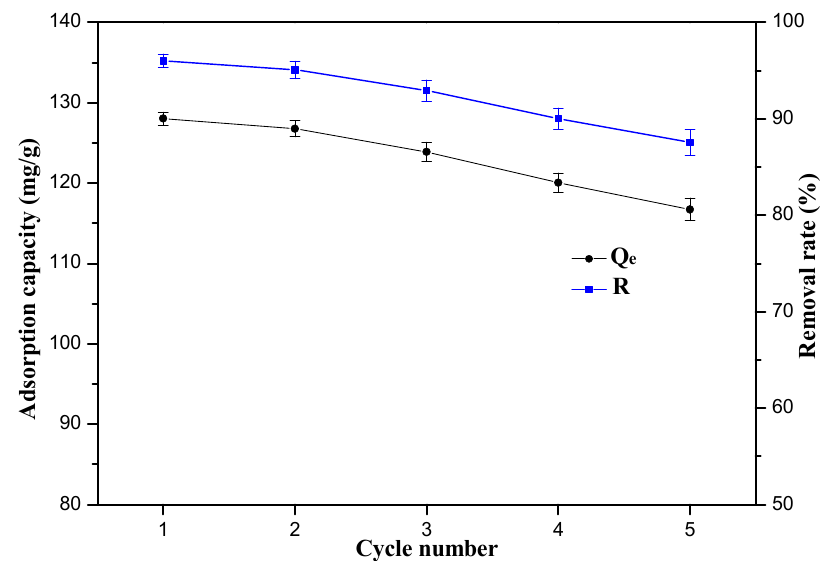
Figure 13. Repeated use of the 10%-Fe 3 O 4 @ SC adsorbent.